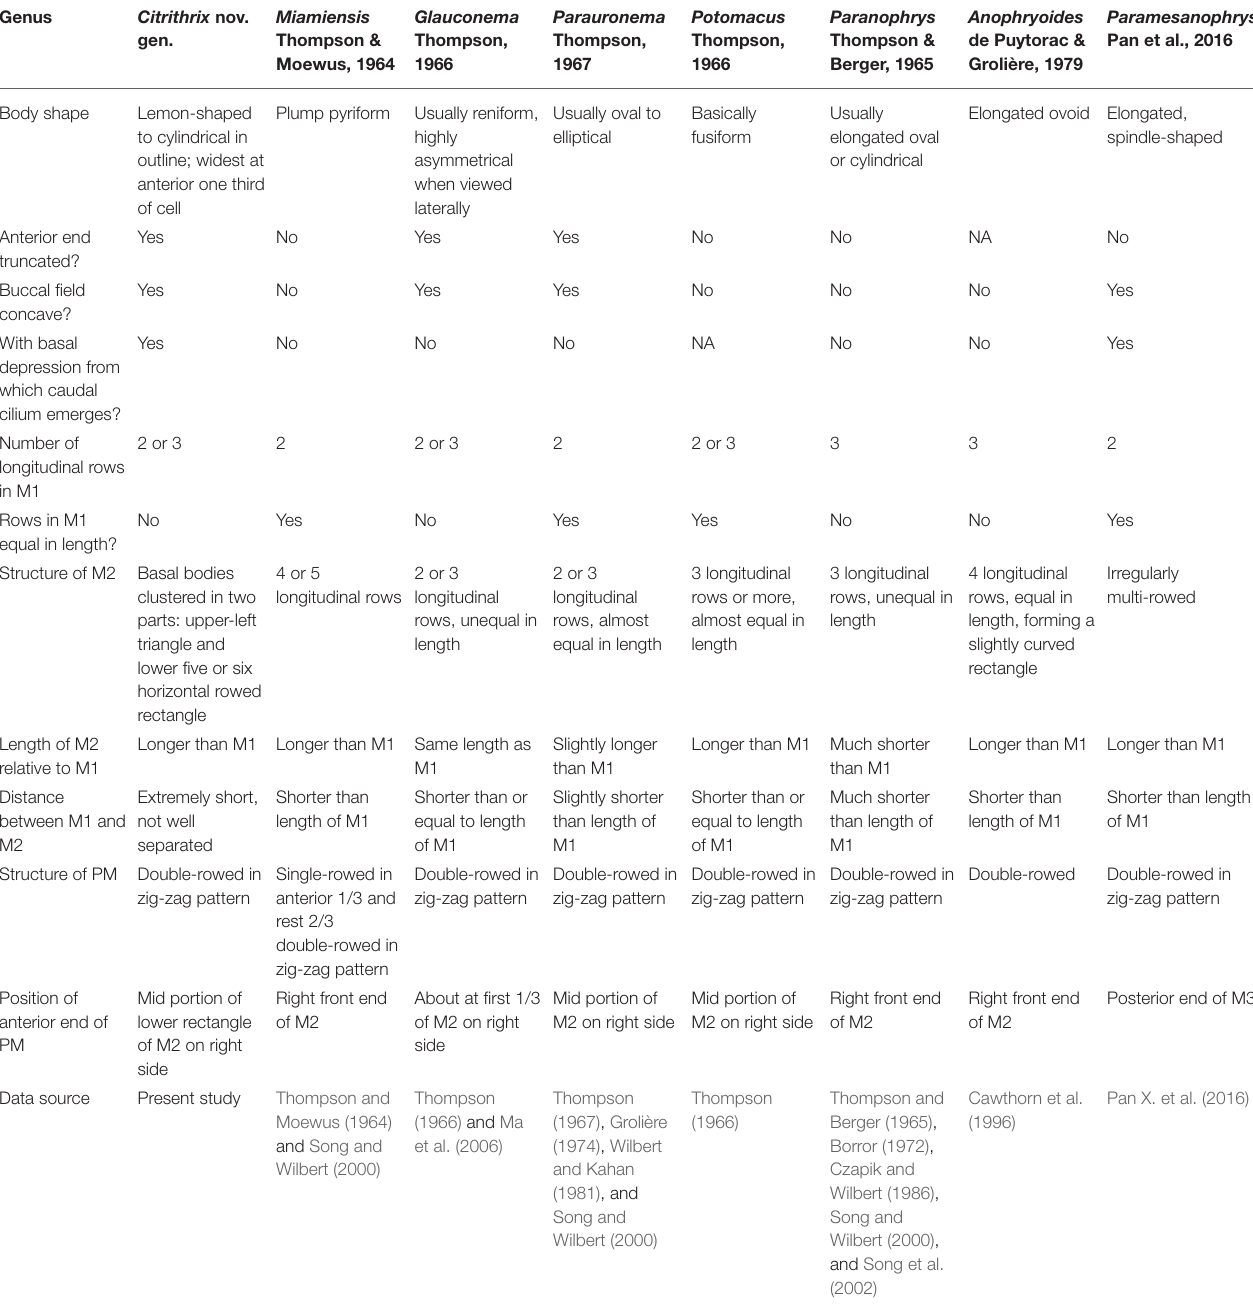
TABLE 2 | Comparison of Citrithrix nov. gen. with related